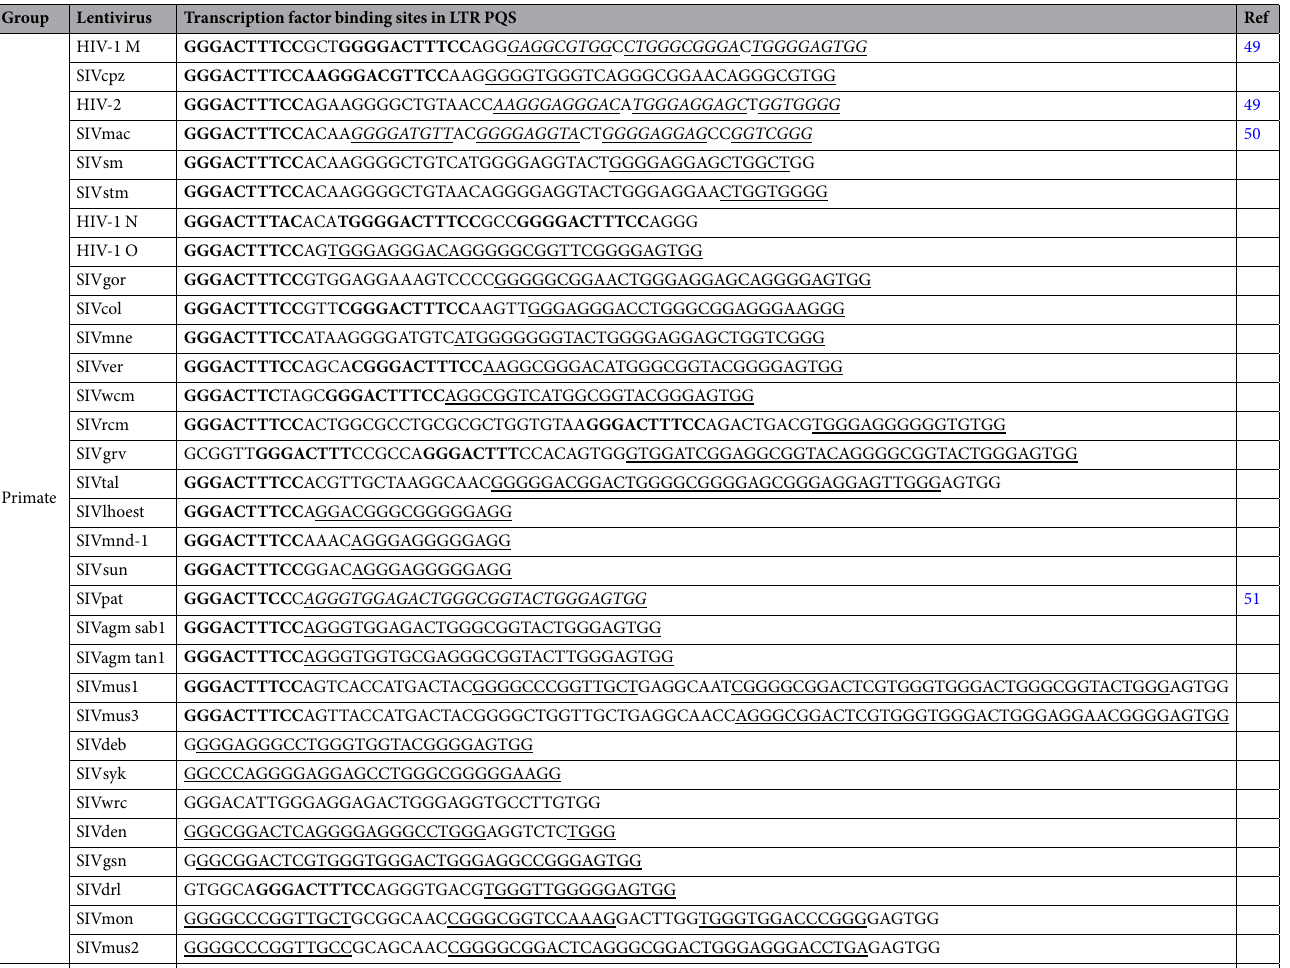
Table 1. Transcription factor binding sites in 5 ′ -LTR PQS. Binding sites for NF κ B are in bold. Sp1 binding sites reported in the literature are indicated in italics and are underlined. Sp1 binding sites predicted by Physbinder are